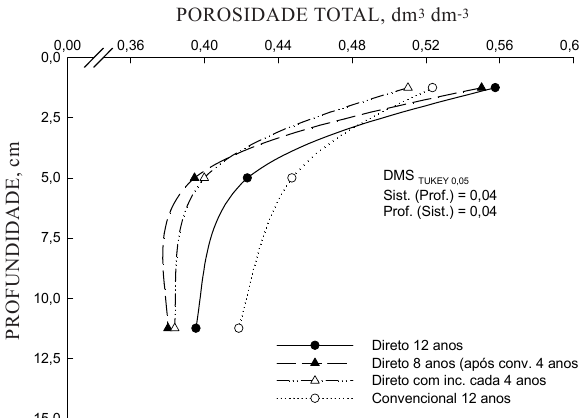
Figura 2. Porosidade total do solo em diferentes sistemas de manejo e